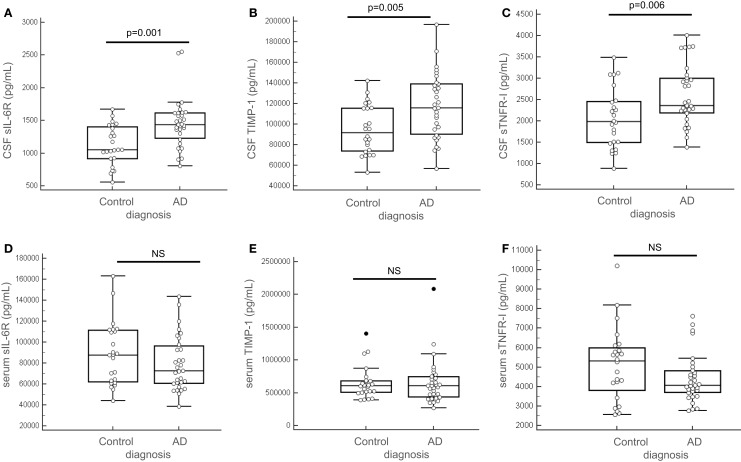
Predictors quantification in the CSF and the serum. sIL-6R, TIMP-1, and sTNFR-I were quantified in the CSF (A–C) and in the serum (D–F) of 55 patients (AD, n = 31 and control subjects, n = 24). Outliers are indicated with black circle. Outliers are defined as a value that is smaller than the lower quartile minus three times the interquartile range, or larger than the upper quartile plus three times the interquartile range.